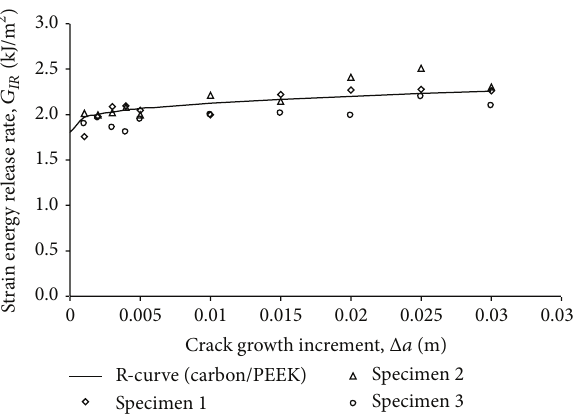
Figure 3: R-curve ( 𝐺 𝐼𝑅 = 199+540(Δ𝑎) 0.3 ) of DCB specimens made of